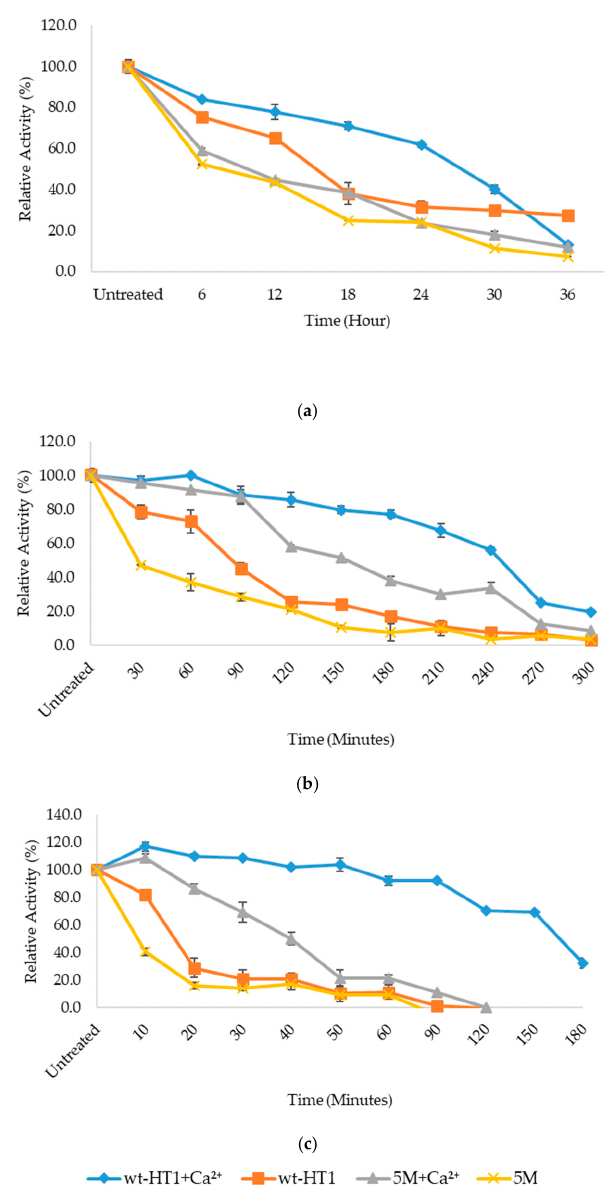
Figure 5. Thermostability of wt-HT1 and 5M mutant lipases. ( a ) Temperature profile at 60 °C. ( b ) Temperature profile at 70 °C. ( c ) Temperature profile at 80 °C.